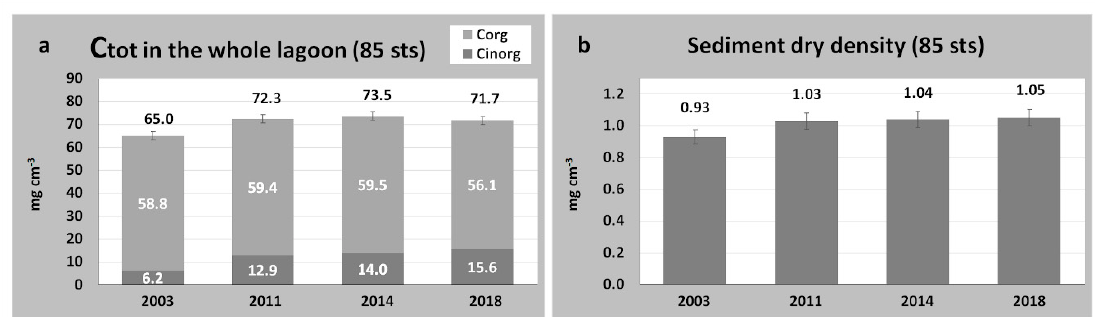
Figure 3. ( a ) Average values of the carbon concentrations recorded in the surface sediments (85 stations) of the whole Venice Lagoon. Data were normalized taking into account the amount of dry sediment (dry density) for volume unit ( b ) and expressed in mg dwt cm − 3 .